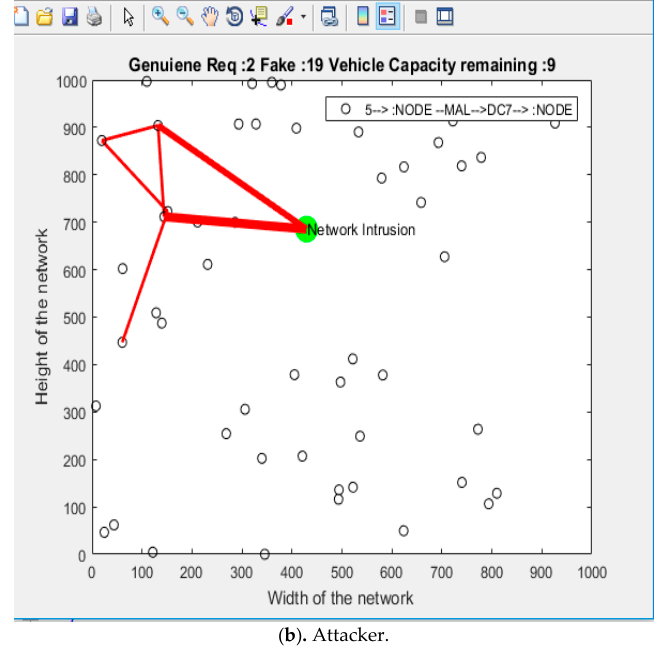
( b ) . Attacker. Figure 7. ( a ) Constructed path; ( b ) attacker. Figure 7 . ( a ) Constructed path; ( b ) attacker. Table 3. Utilized feedforward back propagation neural network (FFBP-NN)